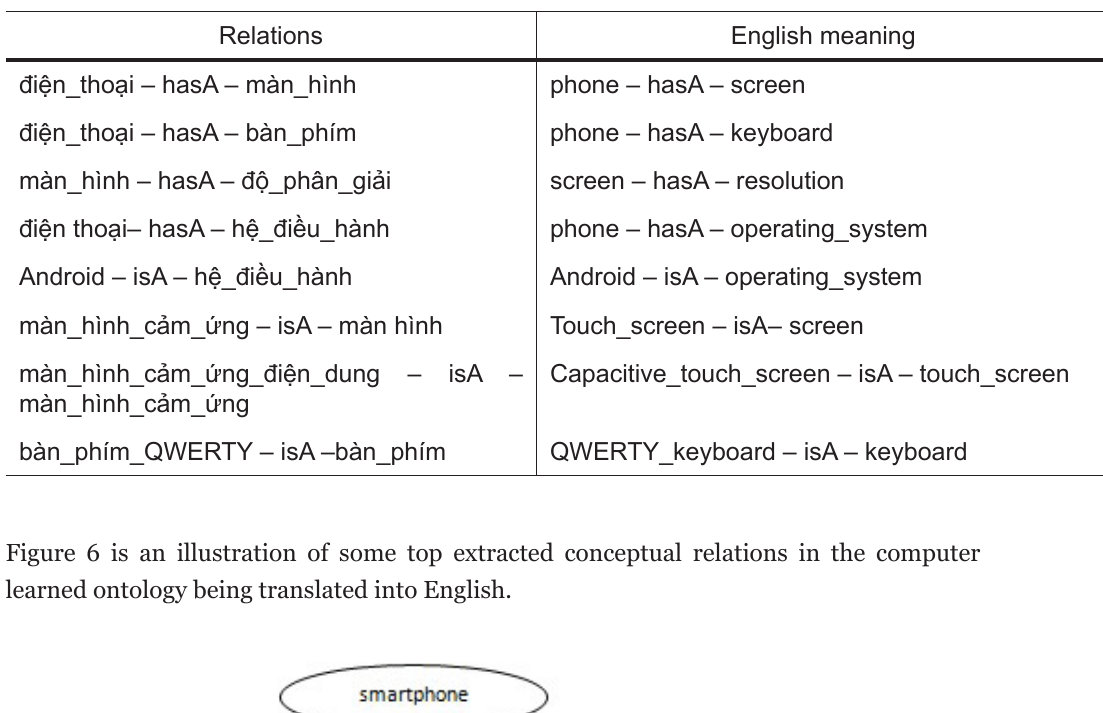
Top Extracted Relations